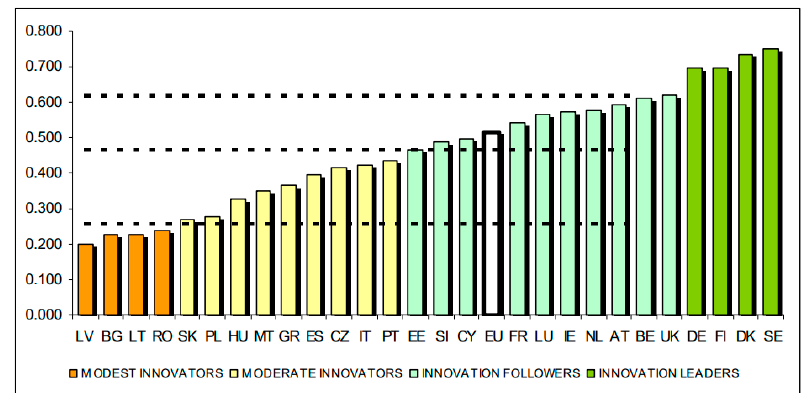
Figure 3. Innovation Performance of European Union Member States. Source: Innovation Union Scoreboard 2010.